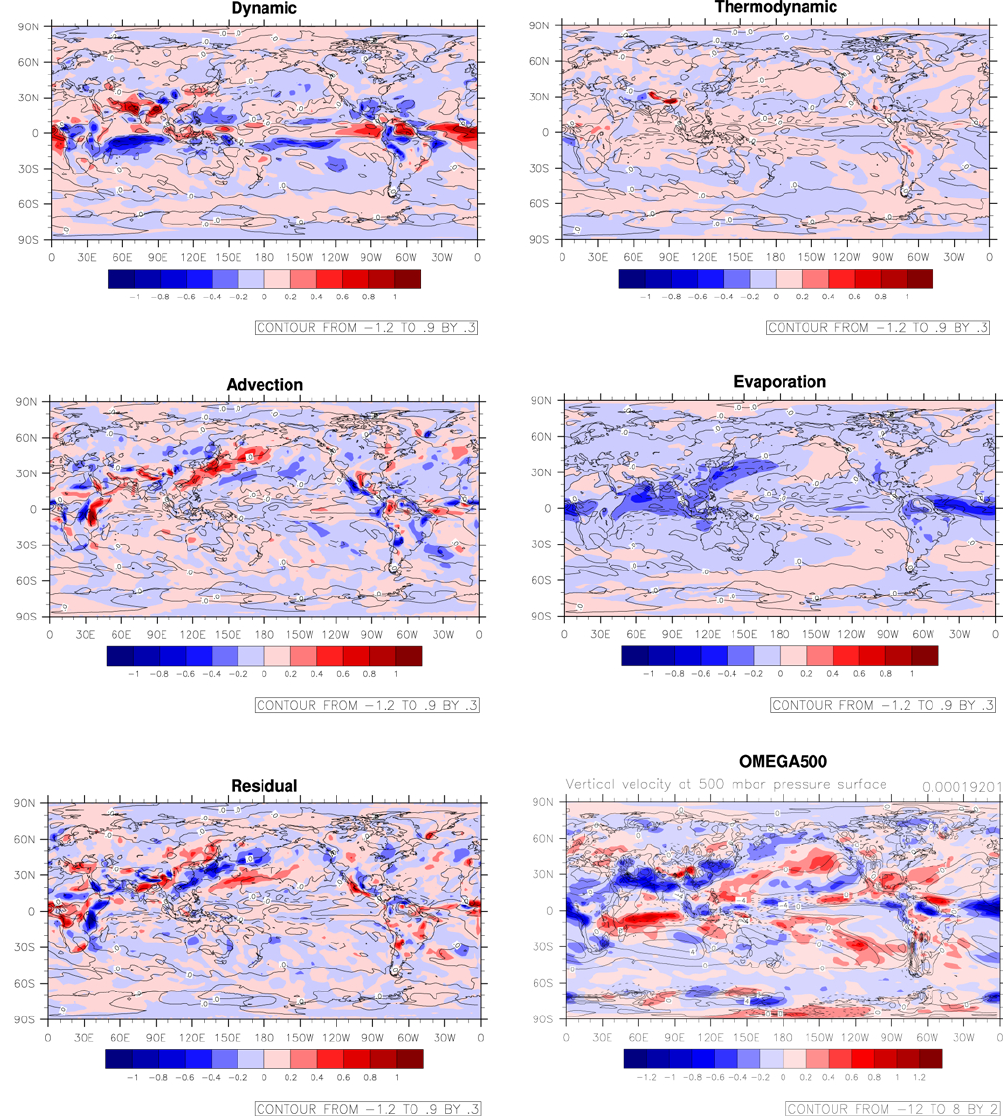
Fig. 14. Same as Fig. 13 but for the fixed SST runs (FSSTc_SOMc and FSSTnc_SOMc). Unit is mmday − 1 .